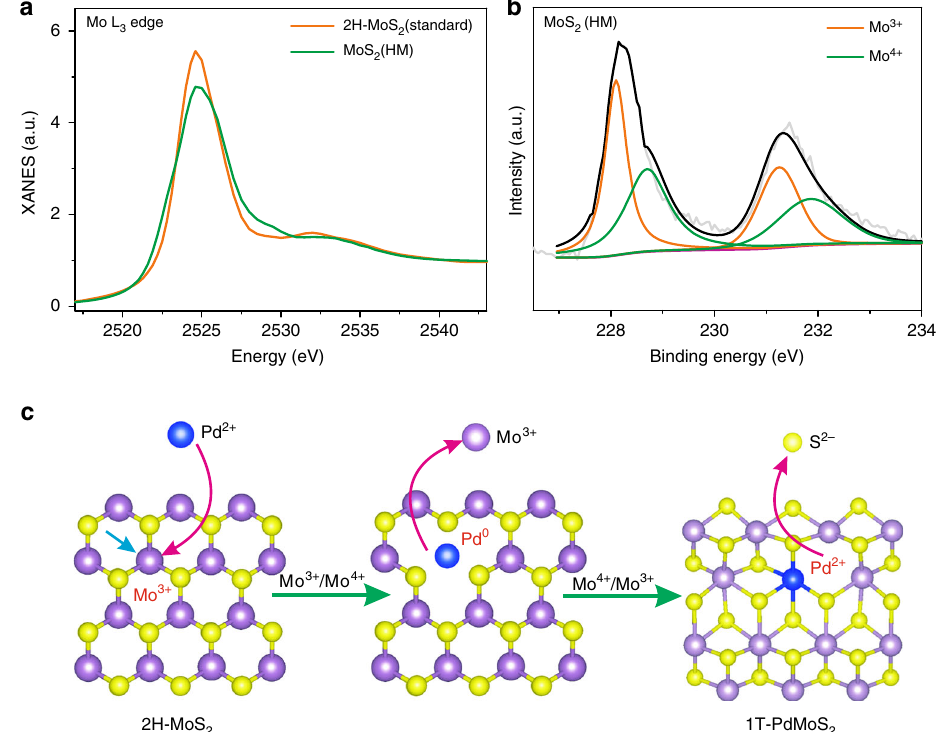
Fig. 1 Design of a Pd – MoS 2 material based on recognizing the redox characteristics of MoS 2 . a Mo L 3 -edge XANES spectra of the homemade MoS 2 . b High- resolution XPS results (Mo 3 d region) of the homemade MoS 2 . c Schematic illustration of the spontaneous MoS 2 /Pd (II) redox